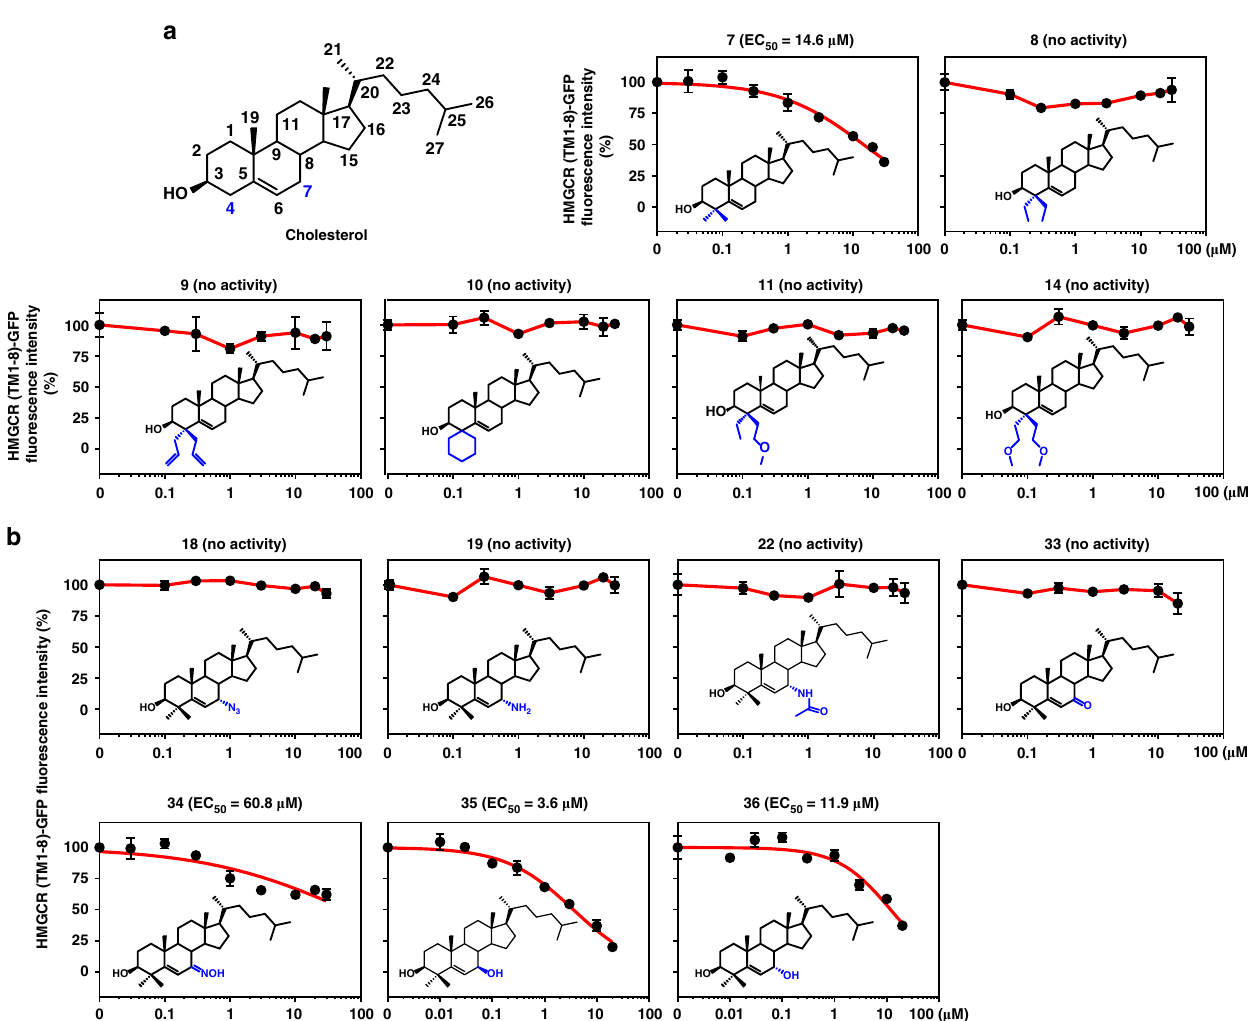
Fig. 3 Identi fi cation of essential structural features of HMGCR degrader. a , b CHG cells were incubated with indicated compounds for 16 h. The GFP intensity of DMSO-treated cells was de fi ned as 100. a Dose – response curves of HMGCR (TM1-8)-GFP fl uorescent intensity to cholesterol analogs with different modi fi cations at C-4 position. 4,4-Dimethyl cholesterol ( 7 ) was able to degrade HMGCR protein. b Dose – response curves of HMGCR (TM1-8)- GFP fl uorescent intensity to 4,4-dimethyl cholesterol derived analogs with different moieties at C-7 position. 4,4-Dimethyl 7 β -hydroxyl cholesterol ( 35 ) had improved activity of inducing HMGCR degradation. Data are from three independent experiments and presented as mean ± SD. Source data are provided as a Source Data